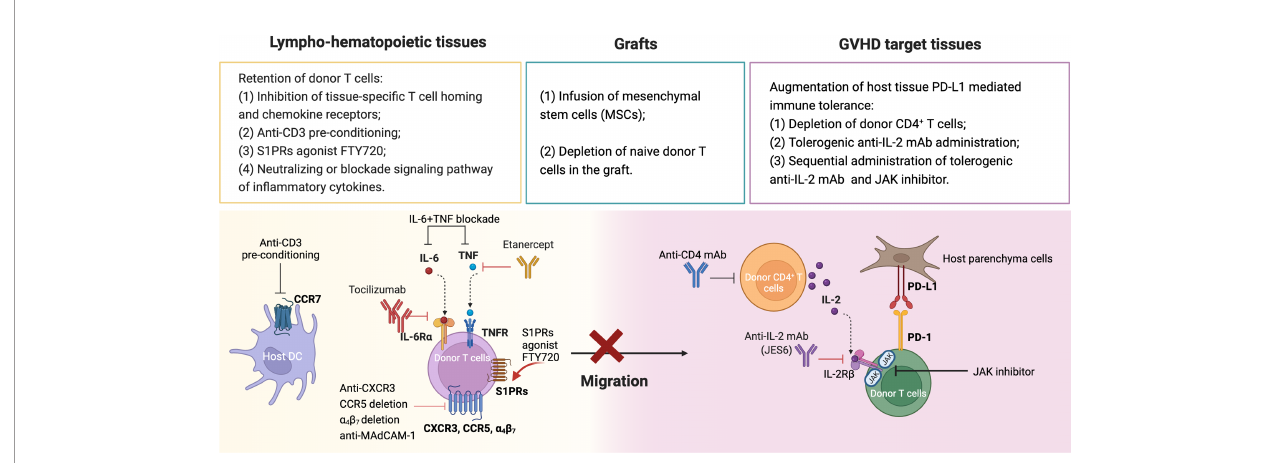
FIGURE 2 | Summary of approaches for prevention of GVHD while preserving GVL activity. (1) Retention of donor T cells in lympho-hematopoietic tissue. (2) Depletion of naïve donor T cells and infusion of mesenchymal stem cells. (3) Augmentation of tissue PD-L1 mediated immune tolerance. Created with BioRender.com.